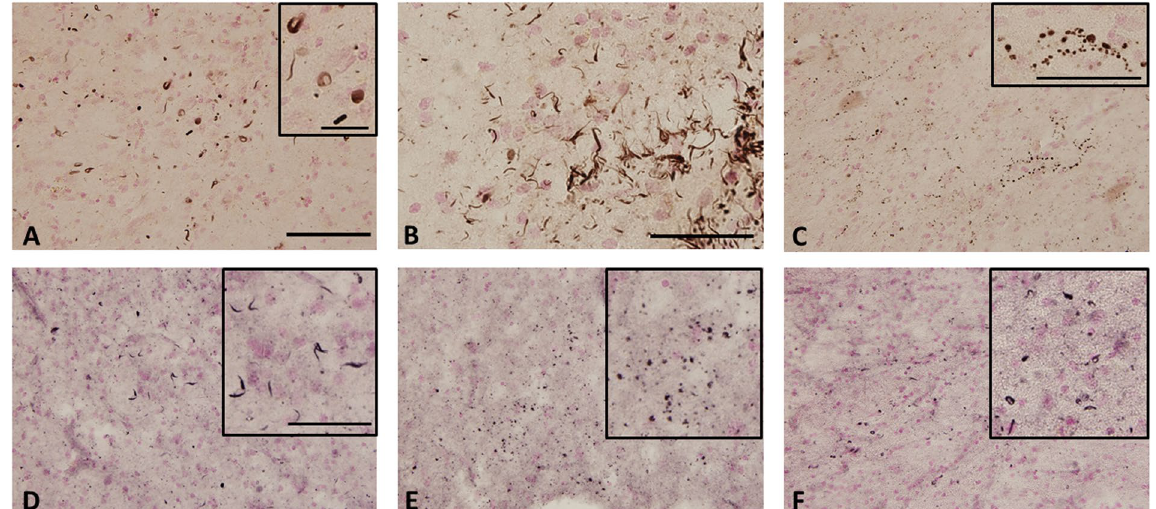
Figure 3. Immunohistochemical staining of phosphorylated α -synuclein in the temporal lobe of the GRN mutation cases. Phosphorylated α -synuclein -positive structures were observed in the inferior temporal cortex ( A ), superior temporal cortex ( B ) and tuberomammillary nucleus ( C ) in case 4, and in the temporal cortex in case 1 ( D ), case 2 ( E ) and case 3 ( F ). Sections were counterstained with Kernechtrot stain solution. The scale bar in ( A ) applies to ( C – F ) (200 μ m). The scale bars in ( B ), in insert ( A , C and D – F ) are 50 μ